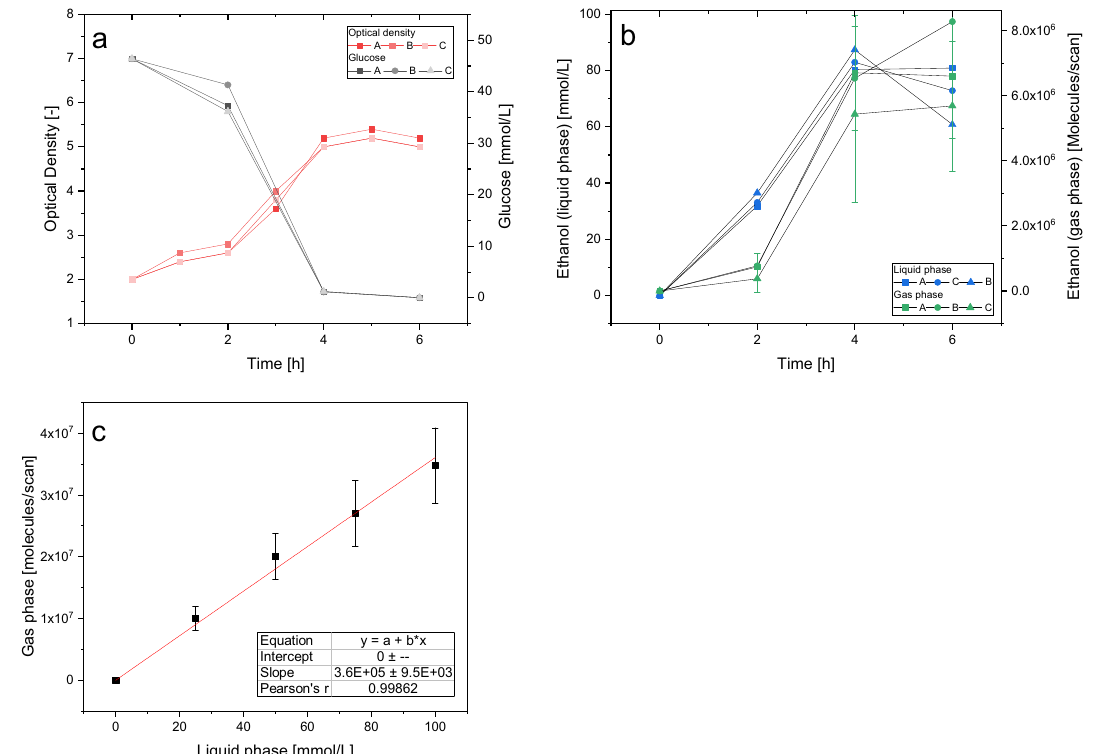
Figure 1. Optical density and glucose concentration of the yeast in shake flasks ( a ). Concentration of ethanol as measured by HPLC (liquid phase) and as intensity SESI-Orbitrap MS (gas-phase), presented are means and SD for n = 3 technical replicates ( b ). Calibration curve of ethanol in the gas phase above an aqueous ethanol solution with 0–100 mM at 30 °C, presented are means and SD for n = 3 technical replicates ( c